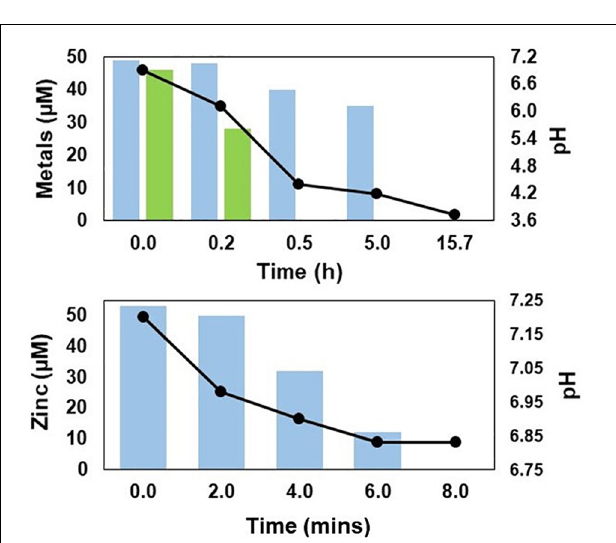
FIGURE 7 | Changes in concentrations of soluble zinc ( (cid:4) ) and copper ( (cid:4) ) (bar graphs), and pH (line graphs) in off-line vessels containing synthetic mine water (top) and actual MIW (bottom) from Force Crag, contacted with H 2 S generated by the HSB.